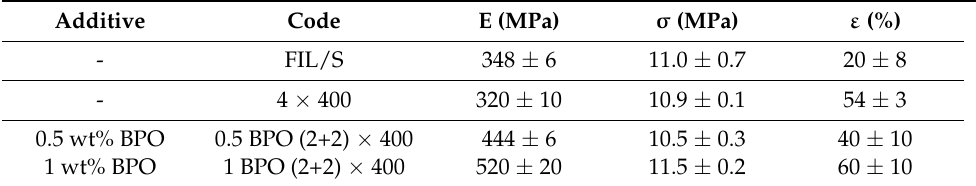
Table 3. Codes and mechanical parameters of the materials treated with BPO, as compared to neat FIL/S and 4 × 400